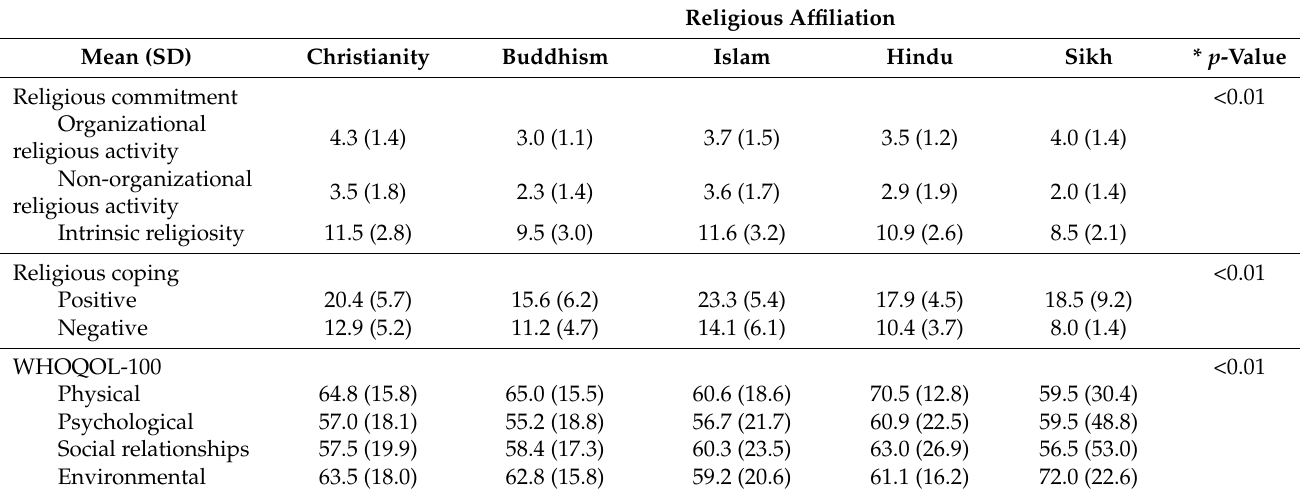
Table 3. Religious coping, religious commitment, and WHOQOL-100 domain scores by religious